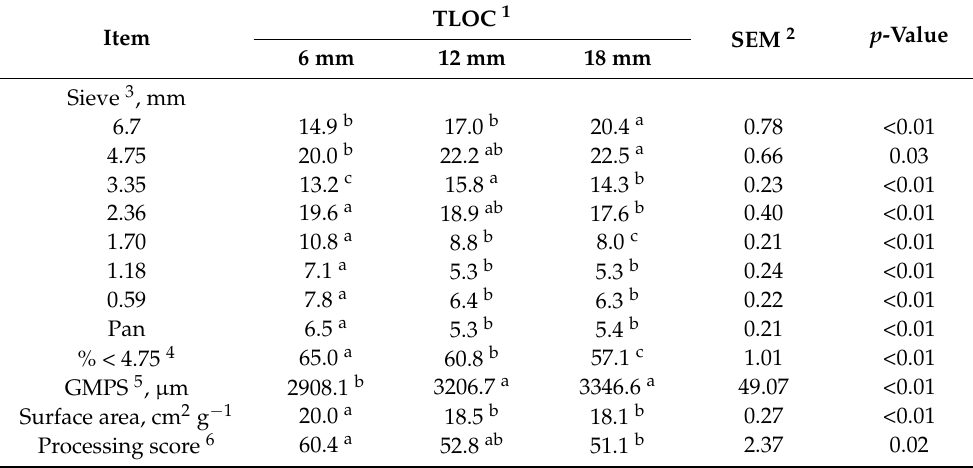
Table 8. Effect of theoretical length of cut on kernel fraction particle size distribution, geometric mean particle size, surface area and processing score in whole-plant corn silage harvested with a self-propelled forage harvester.